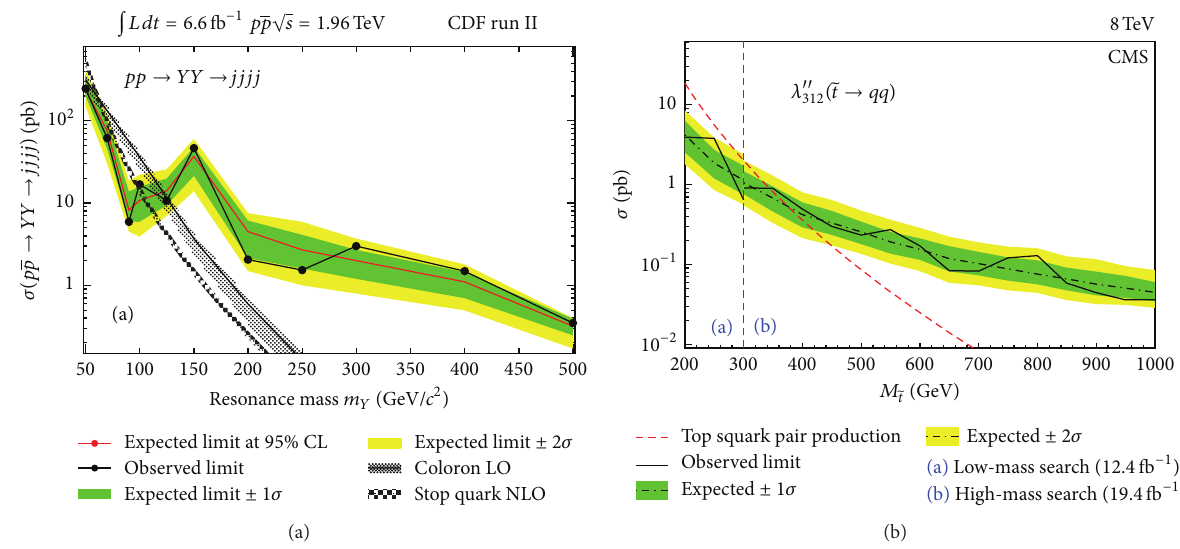
Figure 1: Limits on paired dijet production confronted with the production cross section of a single stop quark at the TeVatron [4] (a) and at the LHC [5] (b). As indicated in the legend, the black solid line represents the excluded cross section for the new physics reaction as a function of the mass of the new state. The green and yellow bands are the total 1𝜎 and 2𝜎 uncertainties on the exclusion. The predicted cross section for the new state is indicated by a solid line per each specific new physics model. The model is excluded for each mass choice for which the predicted cross section is above the